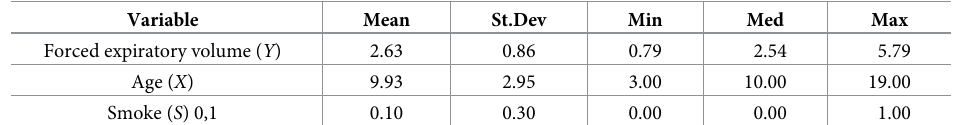
Table 8. Data summary.